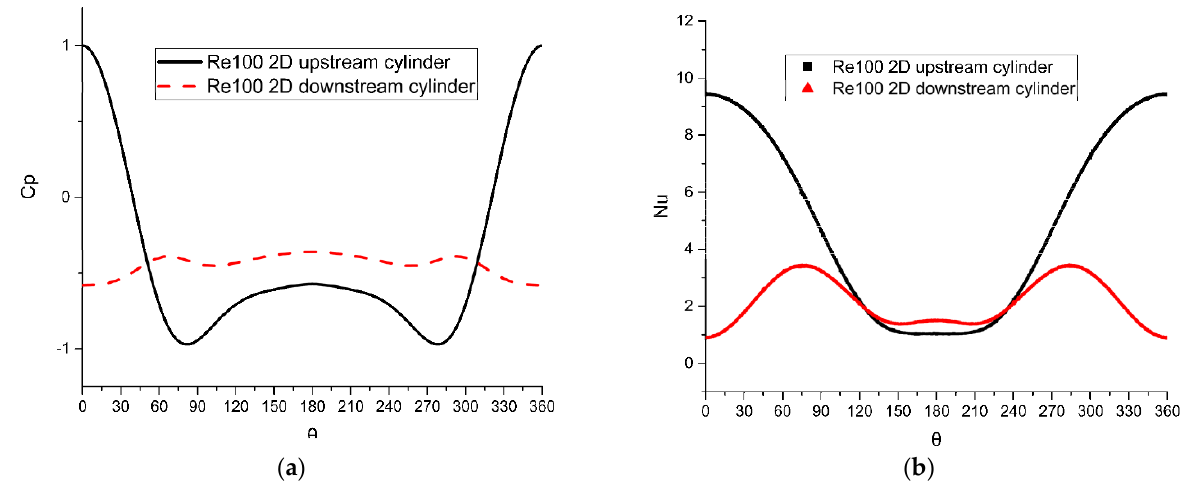
Figure 6. Re = 100, L/D = 2, pressure and Nusselt number distribution around the cylinders: ( a ) surface pressure coefficient; ( b ) Nusselt number.